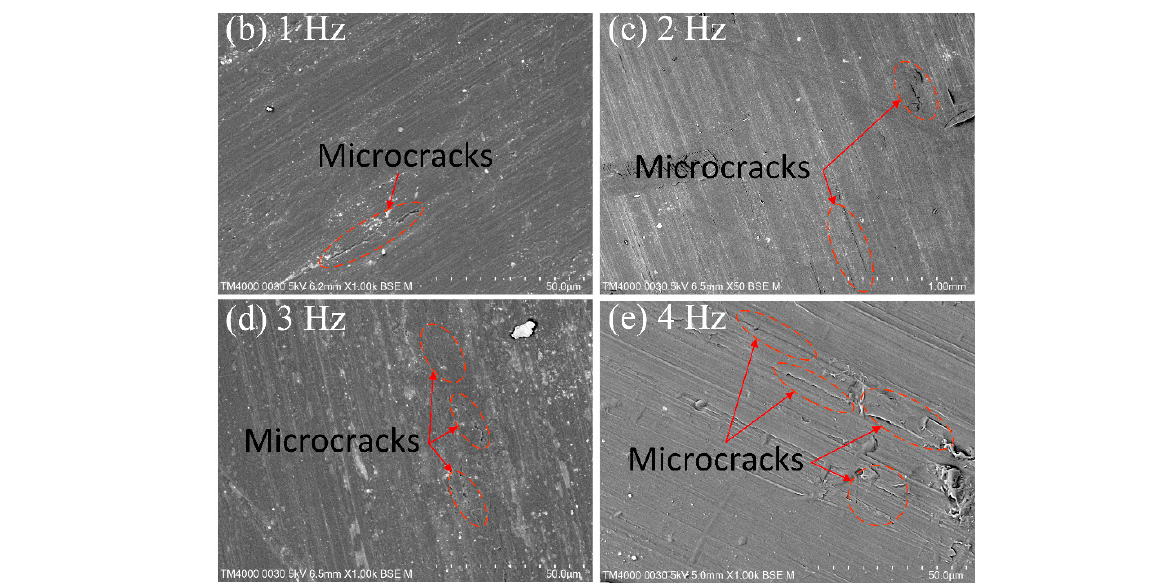
Figure 7. SEM microstructure and EDS spectra of PP samples before and after fatigue at 0.4 mm amplitude and different frequencies: ( a ) SEM microstructure before testing and EDS spectra, ( b ) 1 Hz, ( c ) 2 Hz, ( d ) 3 Hz, and ( e ) 4 Hz.